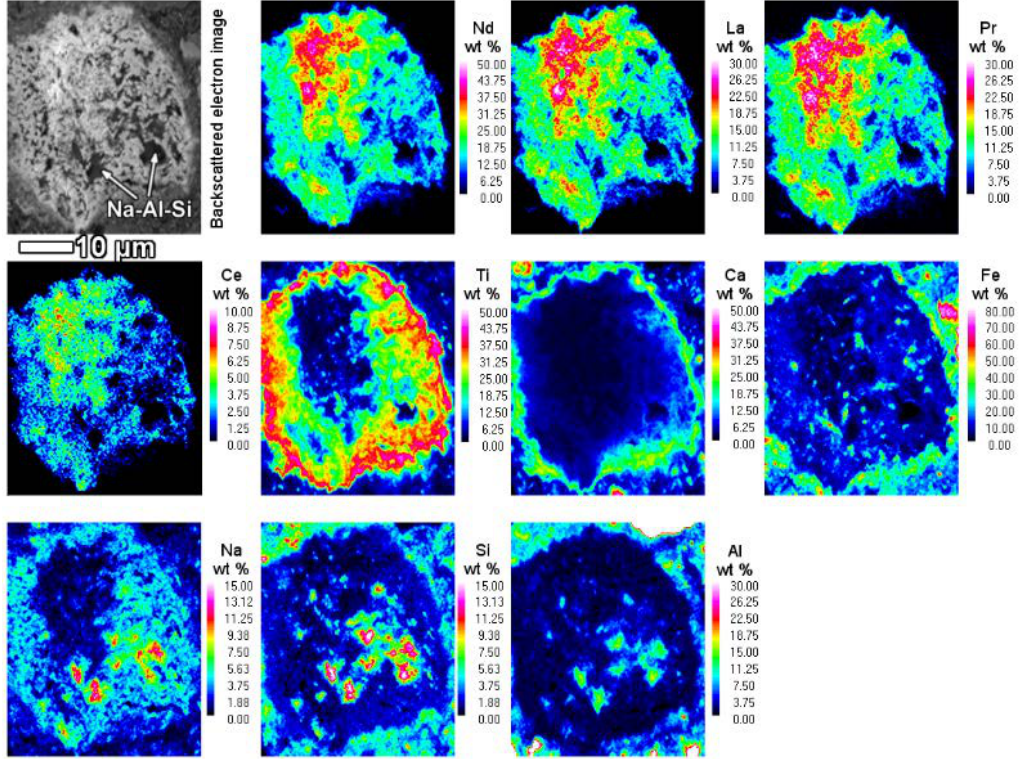
Figure 11. EPMA-WDS quantitative elemental mapping of a reacted LREE particle. The intensely reacted area is also intergrown with sodium aluminosilicate phase (indicated with Na-Al-Si). Mapped area corresponds to Figure 8b.